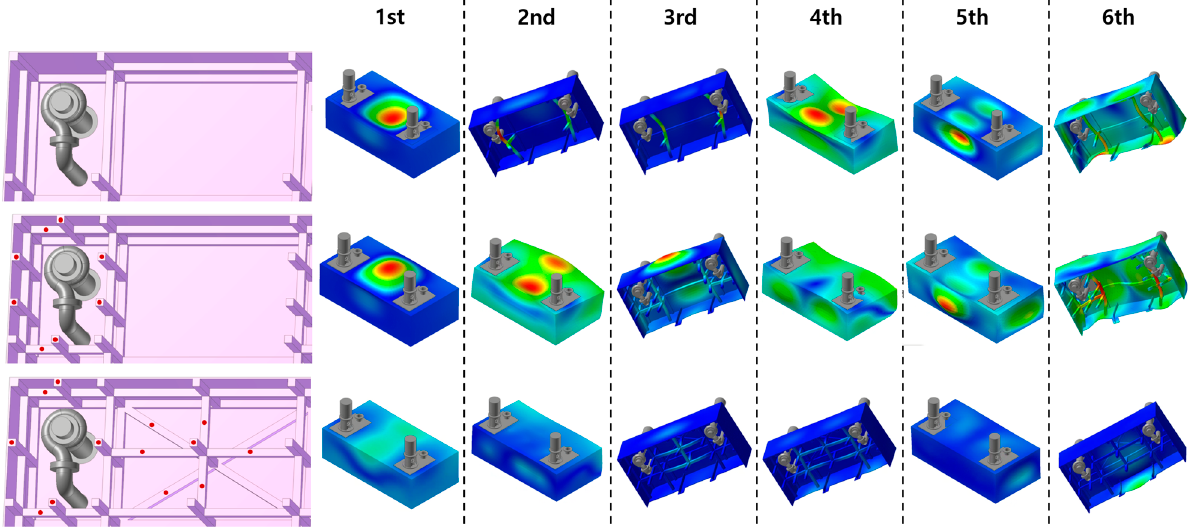
Figure 10. Comparison of mode shape according to structural reinforcement.